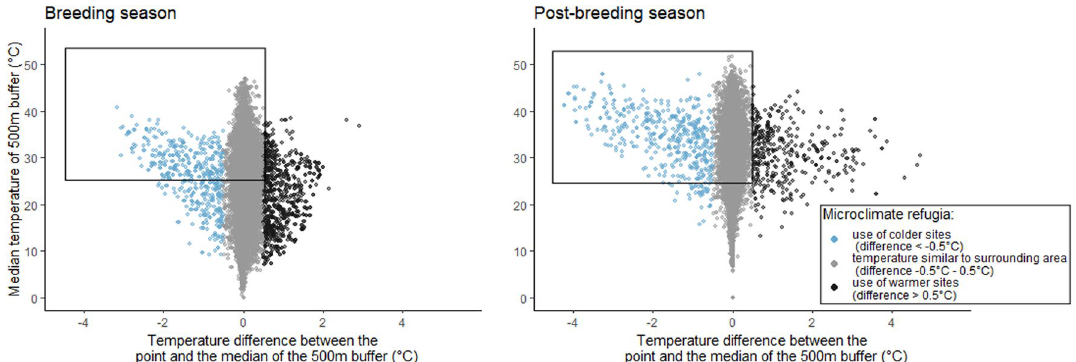
Figure 1. Difference between the temperature of the little bustard locations and the median temperature of the buffer area, for both breeding and post-breeding seasons. The black squares identify the GPS location data used to understand microclimate refugia availability and use by little bustards. Only locations obtained at ambient temperature above 25 °C are included in the analysis where sites with and without cooler microclimate refugia opportunities are